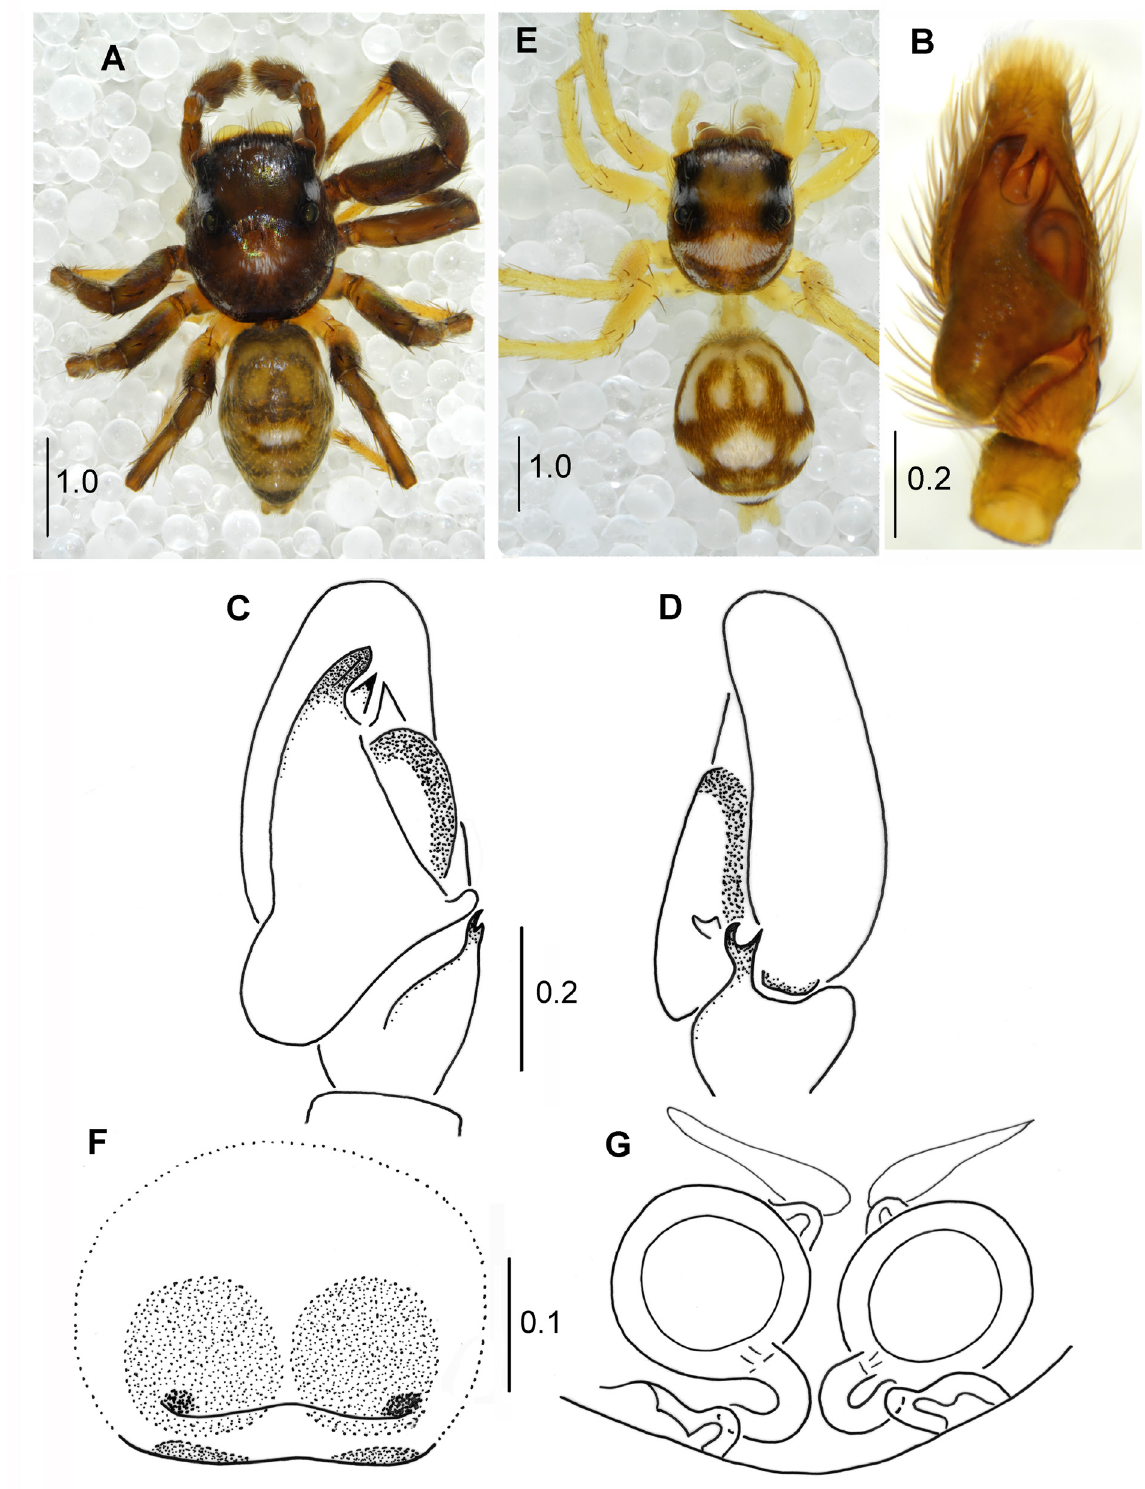
Fig. 48. Phintella paludosa Wesołowska & Edwards, 2012, ♂♀ (MNHN). A . Habitus of male, dorsal view. B–C . Palpal organ, ventral view. D . Palpal organ, lateral view. E . Habitus of female, dorsal view. F . Epigyne. G . Internal structure of